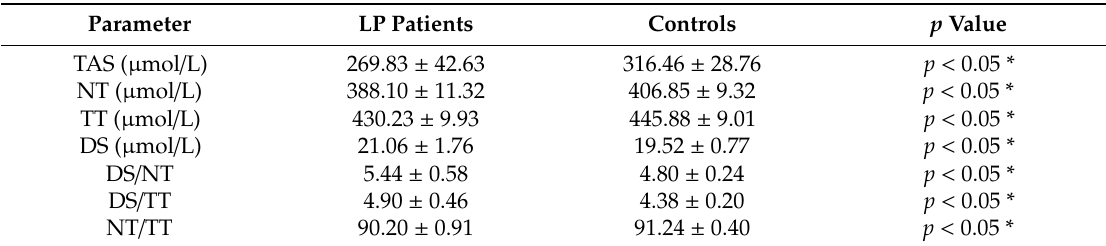
Table 4. The levels of antioxidant markers in LP patients versus controls (expressed as a mean and standard deviation).